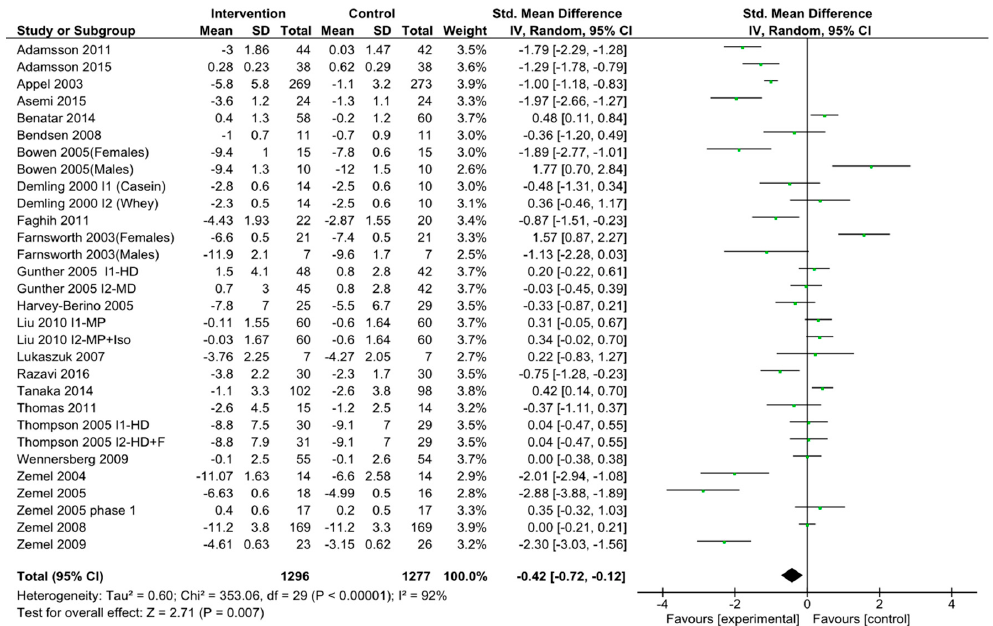
Figure 5. Forest plot of randomized clinical trials of dairy intake and body weight. Body weight change measured in Kg. Abbreviations: F, fiber; Iso, isoflavones; HD, high dairy diet; MD, moderate dairy diet; MP, milk protein.